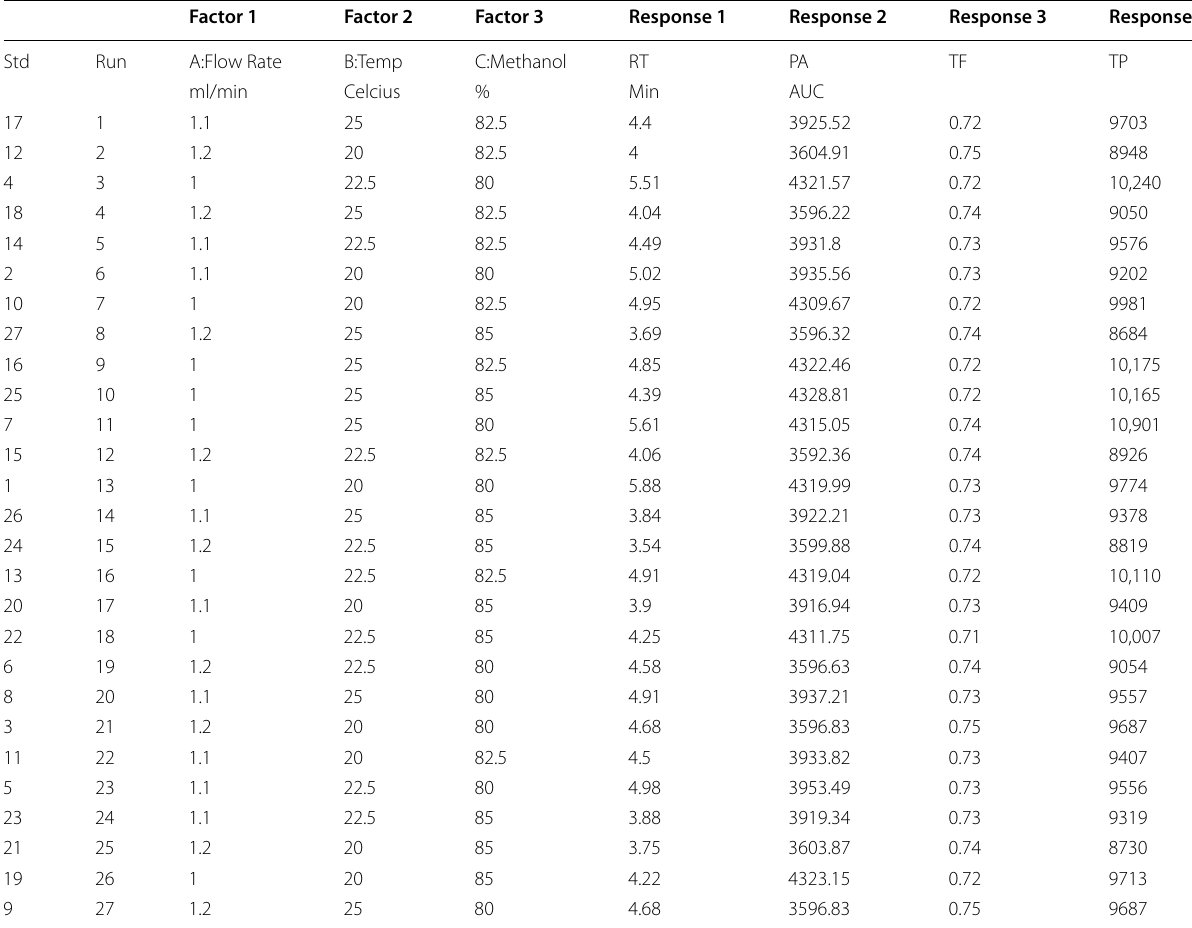
Table 3 Full factorial design matrix (in coded level) along with optimized formulation and experimental data Factor